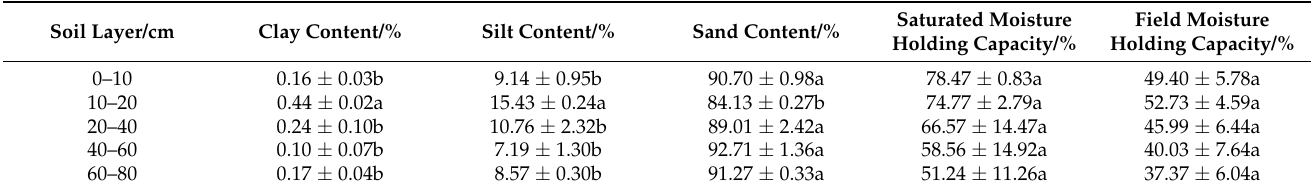
Table 2. Soil particle size composition and maximum and minimum water holding